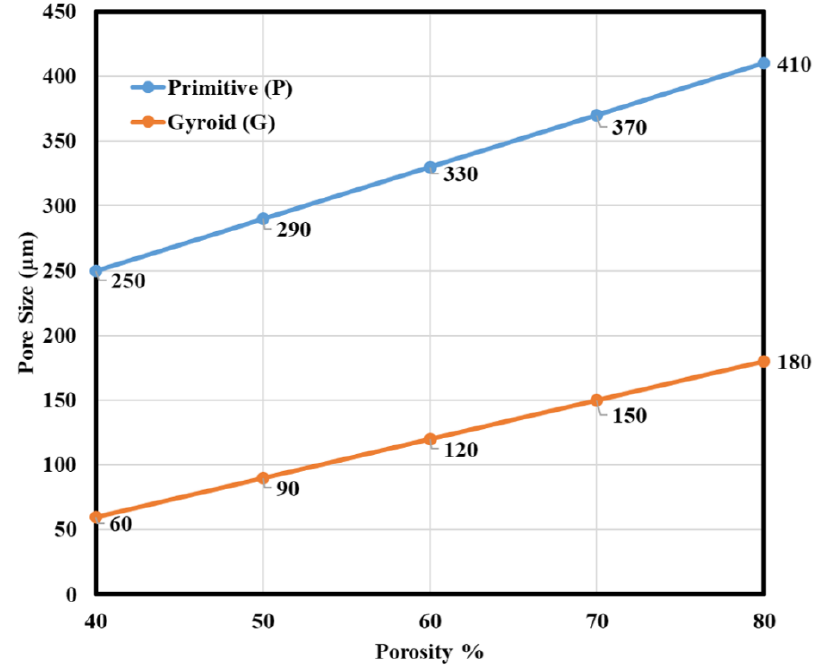
Figure 5. Pore sizes for P and G unit cells for five different porosities ranging from 40% to 80%. Surface area to volume ratio (S/VP) is an important parameter when designing a scaffold with porous unit cells. Previous research on these geometrical aspects claimed that a larger surface area improves cell adhesion and bone ingrowth, as well as promotes cell proliferation metrics [97]. The volume and surface of each unit cell were calculated by CAD measuring features. The surface area increased with the increase of porosity and, contrarily, it decreased as the thickness of cells increased and vice versa. Figure 6a,b are the graphs for strut thickness (t) versus scaffold porosity and surface to volume ratio (S/VP) for P and G structures. Based on the data obtained from the measurement of geometrical parameters, a relationship was developed using a polynomial fit ( R 2 = 1 ) between the thickness parameter (t), scaffold porosity (p), and S/VP ratio. Established Equations (9)–(16) are listed below.